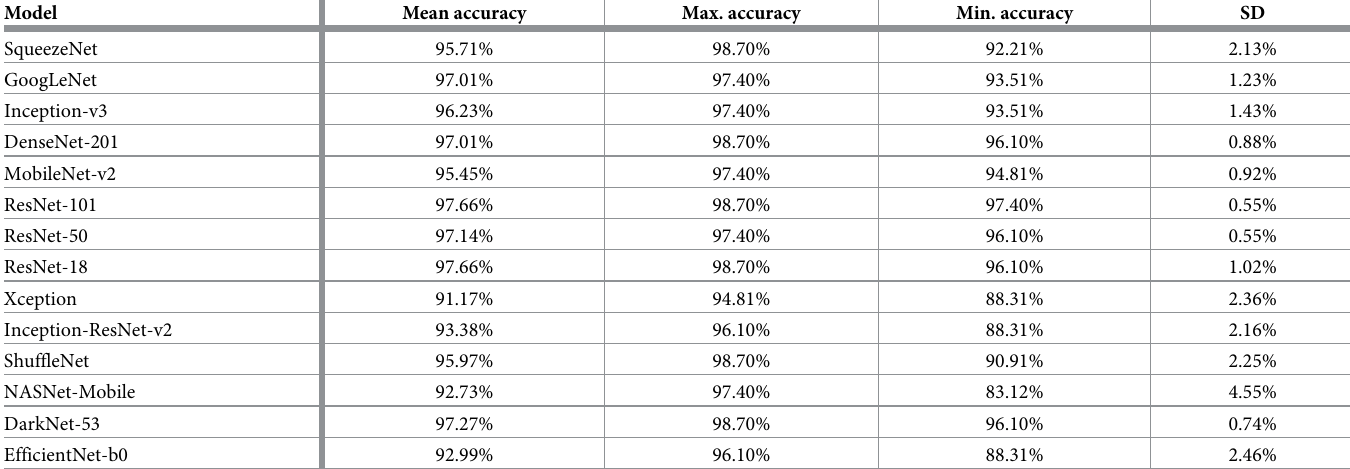
Table 3. The accuracy of classifying X-ray images into two classes; normal or scoliosis, for each deep learning model. The results are reported for 40 runs of each model.